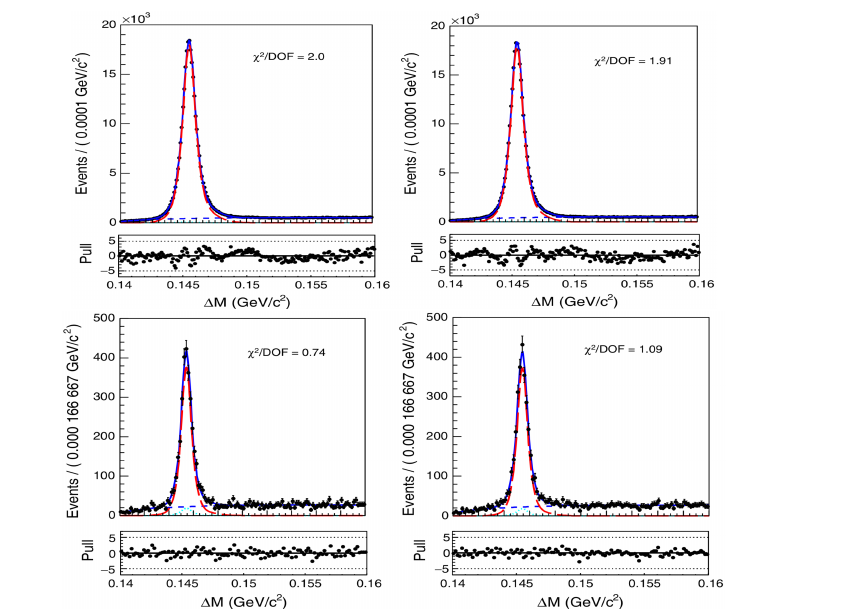
Figure 3. Distributions of the mass di ff erence ∆ M for selected D (cid:3) + (left) and D (cid:3)(cid:0) (right)